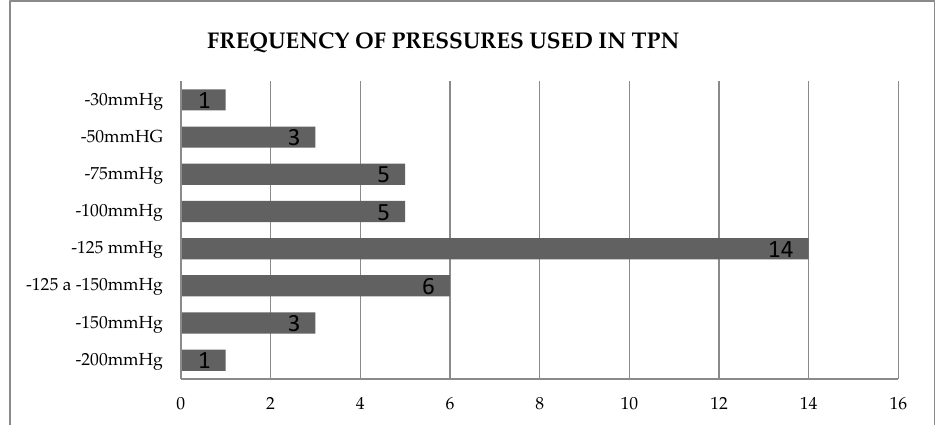
Figure 1. Pressures used in the articles included in the review [17,18,21,22,24,26,29]. Regarding the time between cures for the application of NPT, the most frequent values recorded in cases are 2 days [17,18,21,22,24] and 3 days [18,19,22,26,29]. To a lesser extent, the literature shows a spacing between cures of intervals of 2–3 days [17,18,28,30] and equal to or greater than 4 days [18,22,27,29,31] (Figure 2).